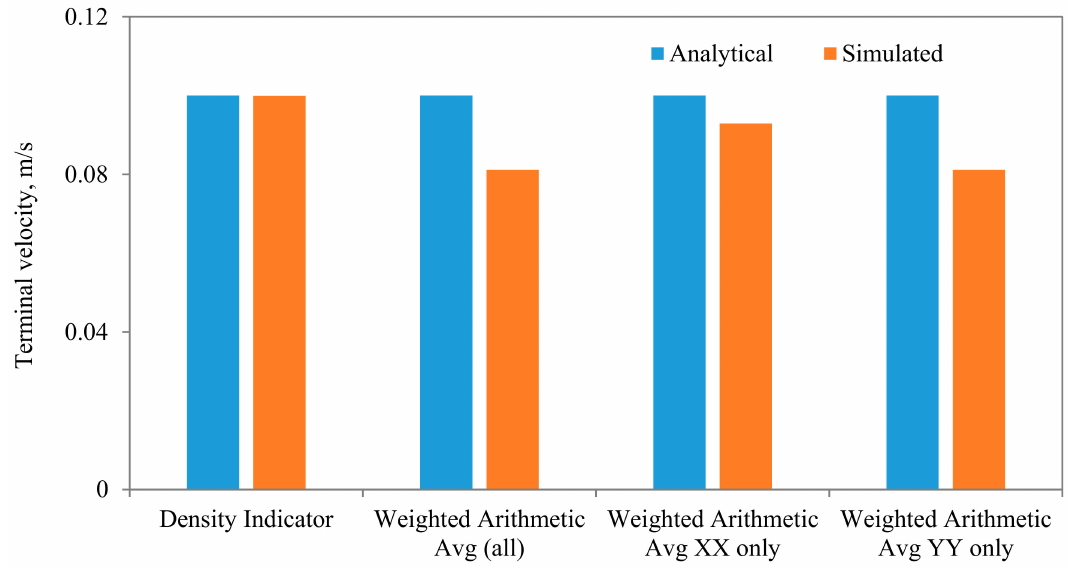
Figure 15. Comparisons between the terminal settling velocity and the simulated one for different diameter to width ratios. In these simulations, the following parameters are held fixed: µ f = 0.001 Pa · s, µ p = 1000 Pa · s, Mesh n x = 40, n y = 80.